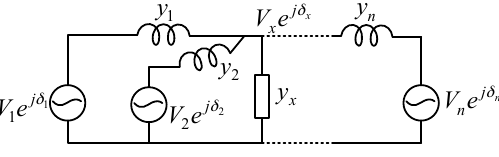
Figure 5. Equivalent circuit of an n- DG MG.